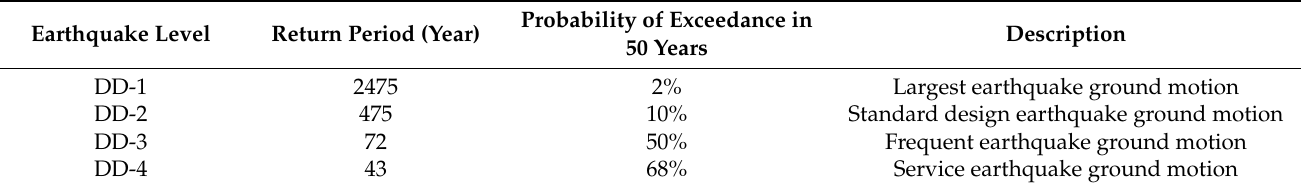
Table 2. Earthquake ground motion levels [74].